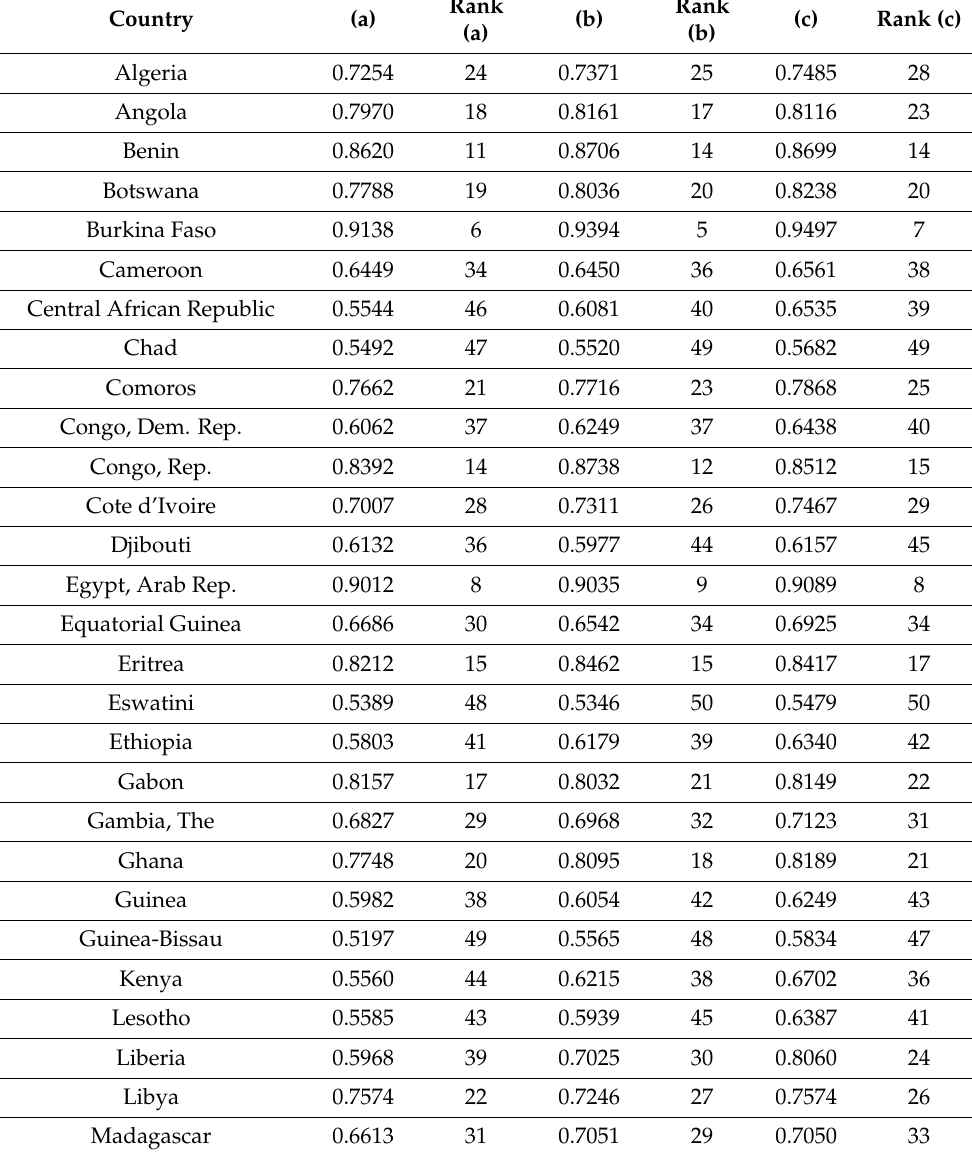
Table 13. Cumulative results for the index of r ref − i access to electricity—CO 2 emissions pc. Source: own